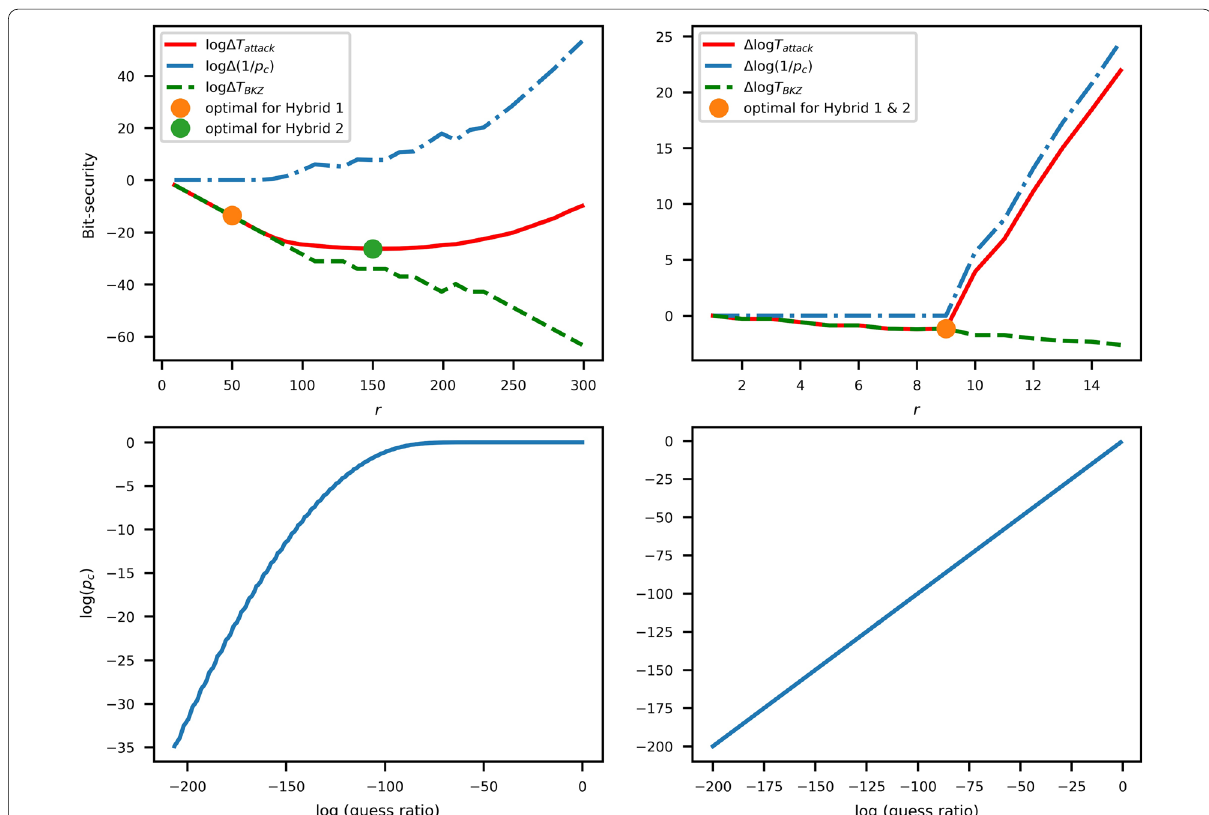
Fig. 5 Comparison between LAC192 (left) and Dilithium768 (right). Figures in the first row plot T Hybrid2 , T BKZ , and p c in function of r ; Figures in the second row visualize the impact of centralization level over p